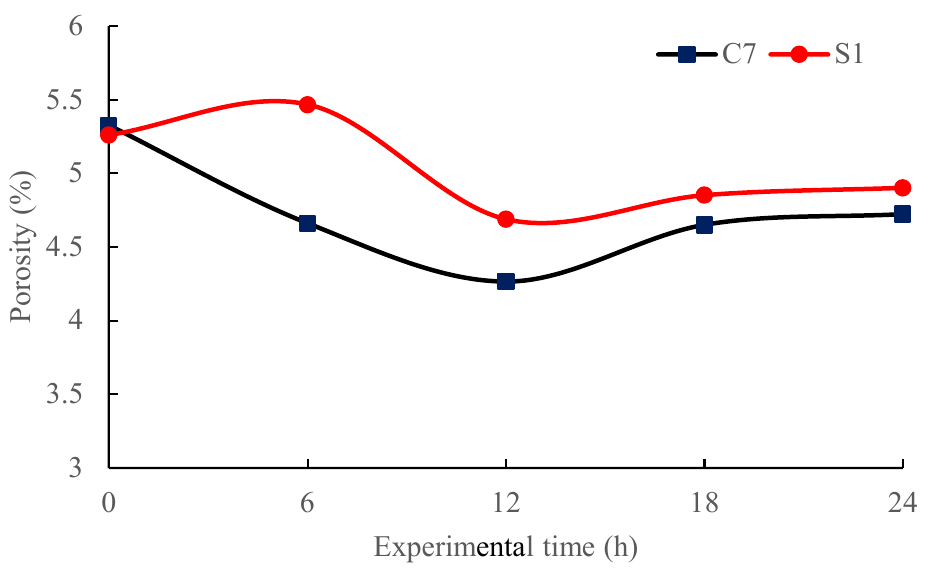
Figure 13. Porosity changes of short-interval (24 h) experiment.